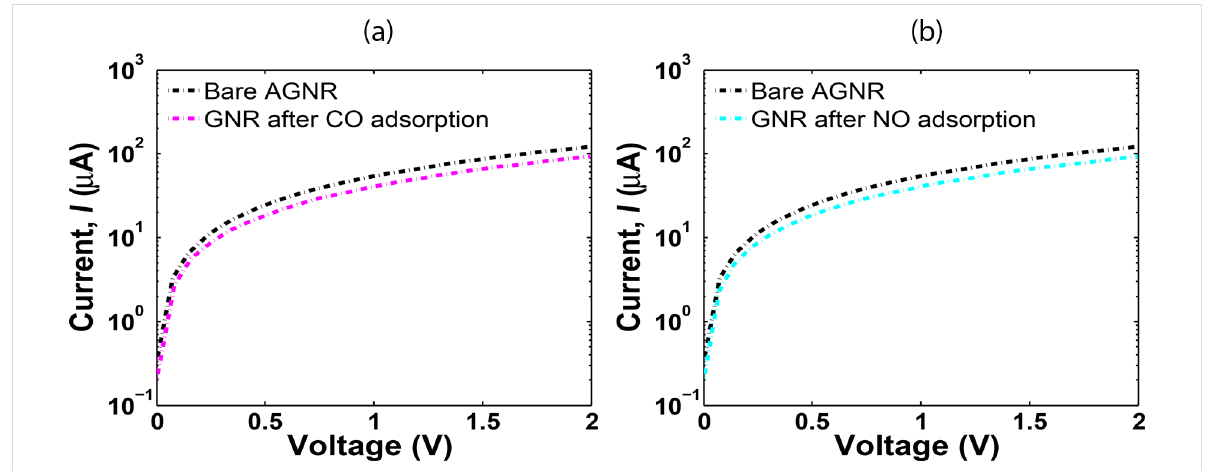
Figure 6: Armchair graphene nanoribbon (AGNR) sensor I – V characteristics obtained using the Atomistix Toolkit (ATK): (a) after CO and (b) after NO.